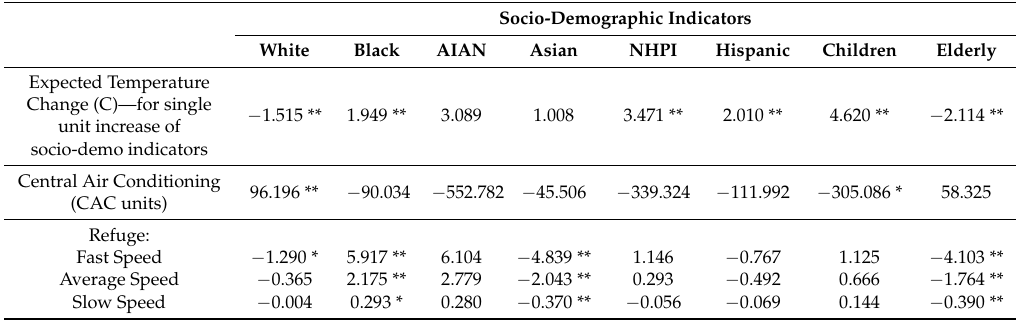
Table 4. Results of covariance analysis: relationship between socio-demographic factors (independent variable), heat exposure, and refuge (dependent variables). Socio-Demographic Indicators White Black AIAN Asian NHPI Hispanic Children